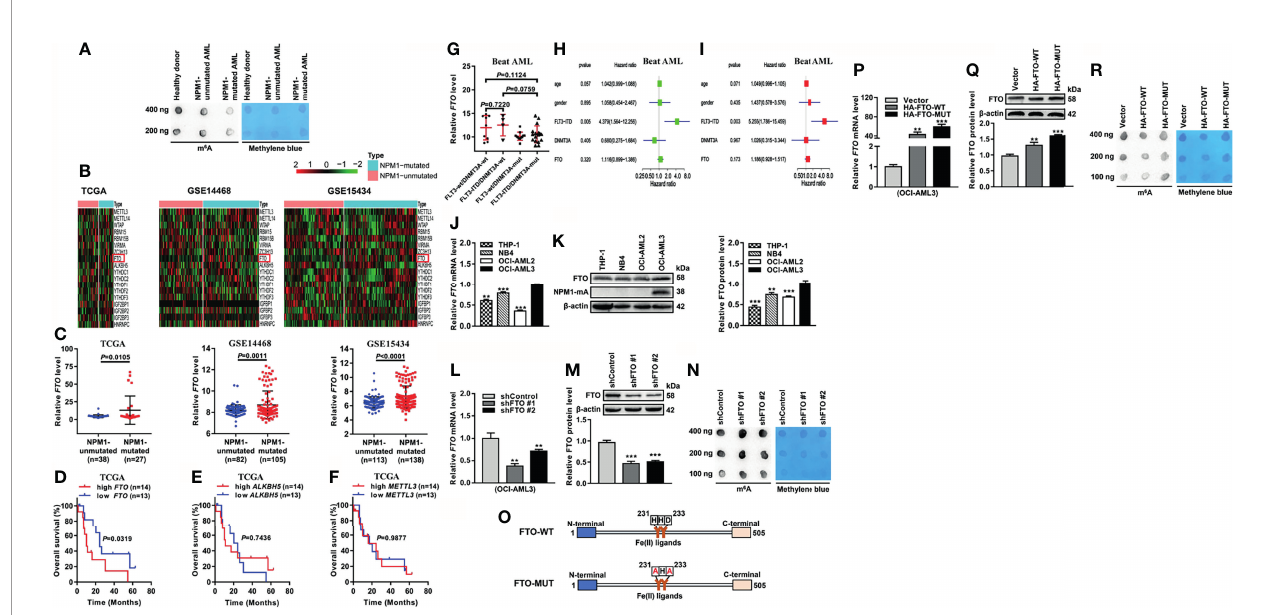
FIGURE 1 | Decreased m 6 A Level is Mediated by FTO Upregulation in NPM1-mutated AML. (A) m 6 A dot blot analysis of the global m 6 A abundance in NPM1- mutated AML, NPM1-unmutated AML, and healthy donor samples. Methylene blue staining served as a loading control. (B) Heatmaps of m 6 A-related genes in AML patients with NPM1 mutations and without NPM1 mutations from TCGA (n=65), GSE14468 (n=187), and GSE15434 (n=251) datasets. (C) The expression patterns of FTO transcript in NPM1-mutated AML samples compared to NPM1-unmutated AML samples from the above three public datasets. (D – F) Survival analysis based on FTO, ALKBH5, METTL3 mRNA expression in TCGA primary NPM1-mutated AML samples. Survival analysis was performed using Kaplan – Meier method. (G) The expression patterns of FTO transcript in NPM1-mutated AML samples from Beat AML dataset (n=42). (H) Univariate Cox regression analyses of the association between clinicopathological factors (including FTO expression) and overall survival of NPM1-mutated AML patients from Beat AML dataset (n=42). (I) Multivariate Cox regression analyses of the association between clinicopathological factors (including FTO expression) and overall survival of NPM1-mutated AML patients from Beat AML dataset (n=42). (J, K) qRT-PCR and western blot analysis of the FTO expression in a panel of human acute myeloid leukemia cell lines. (L, M) qRT-PCR and western blot analysis of the FTO mRNA and protein level in OCI-AML3 cells infected with two independent shRNAs targeting FTO or a control shRNA. b -actin was used as the internal control. The bar graph showed the relative level of FTO protein. (N) m 6 A dot blot analysis of the global m 6 A abundance in the FTO-silenced OCI- AML3 cells. Methylene blue staining served as a loading control. (O) Schematic presentation of the FTO domains and point mutations. (P, Q) qRT-PCR and western blot analysis of the FTO mRNA and protein level in OCI-AML3 cells following transfection of the HA-FTO-WT and HA-FTO-MUT plasmids. b -actin was used as the internal control. The bar graph showed the relative level of FTO protein. (R) m 6 A dot blot analysis of the global m 6 A abundance in OCI-AML3 cells following transfection of the HA-FTO-WT and HA-FTO-MUT plasmids. Methylene blue staining served as a loading control. Data are presented as the mean ± SD of three independent experiments. ** P < 0.01, *** P <